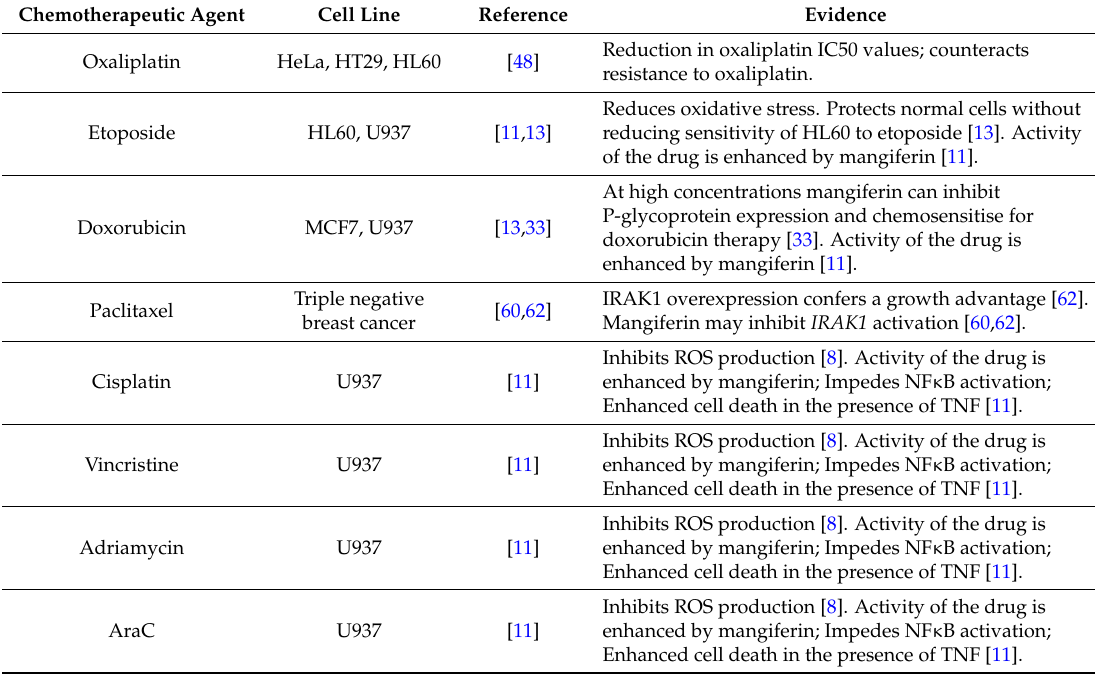
Table 1. Summary of proposed beneficial effects of co-administration of mangiferin alongside chemotherapeutic